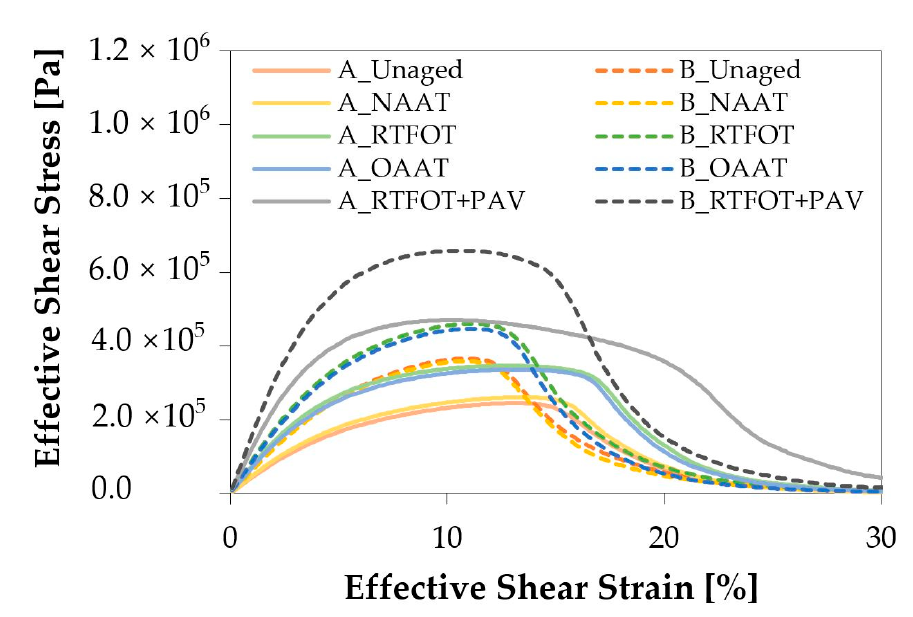
Figure 6. Shear stress (Pa) versus shear strain (%).